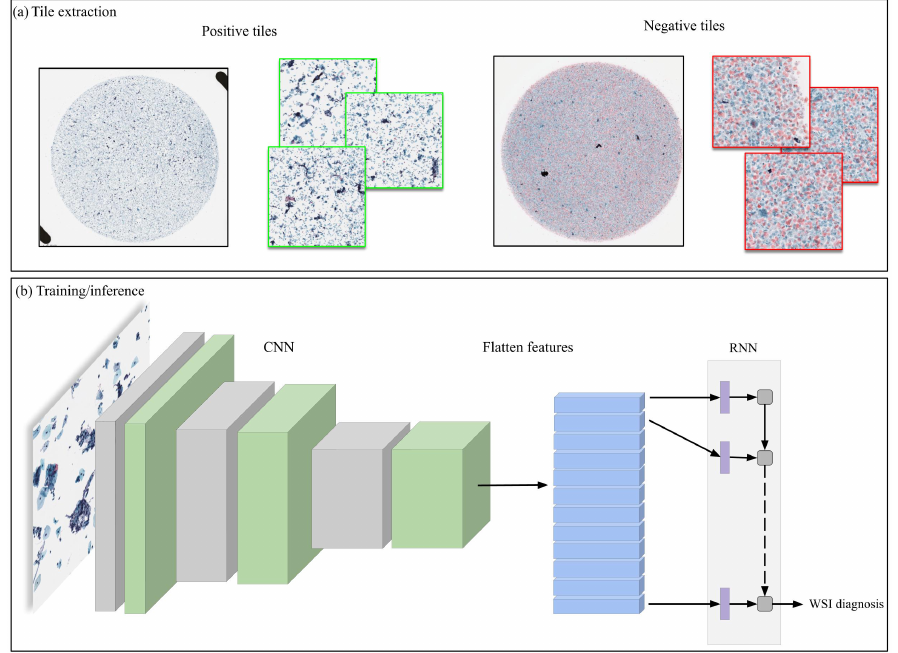
Figure 2. Method overview. ( a ) Large 1024 × 1024 are extracted from the WSIs; for the neoplastic WSIs, tiles are extracted only from annotated regions, while from NILM WSIs, tiles are extracted randomly from any region. ( b ) The tiles are then used to create random balanced batches used to train the model, which is composed of a CNN and an RNN and are trained simultaneously. During inference, the model is applied on all of the tiles of the WSIs in a sliding window fashion, and the WSI label is predicted based on the maximum probability from all of the